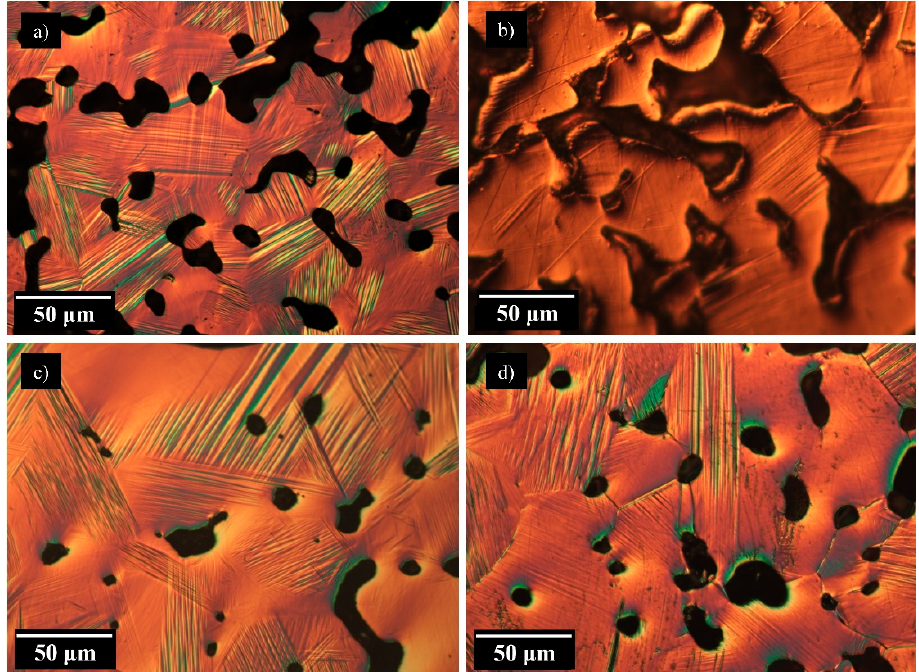
Figure 4. DIC micrographs of polished samples for the investigated materials during this study. The top row presents the 1080 °C sintered sample ( a ) and 1080 °C sintered + heat-treated sample ( b ), respectively, whereas the bottom row presents the 1090 °C sintered sample ( c ) and 1090 °C sintered + heat-treated sample ( d ).